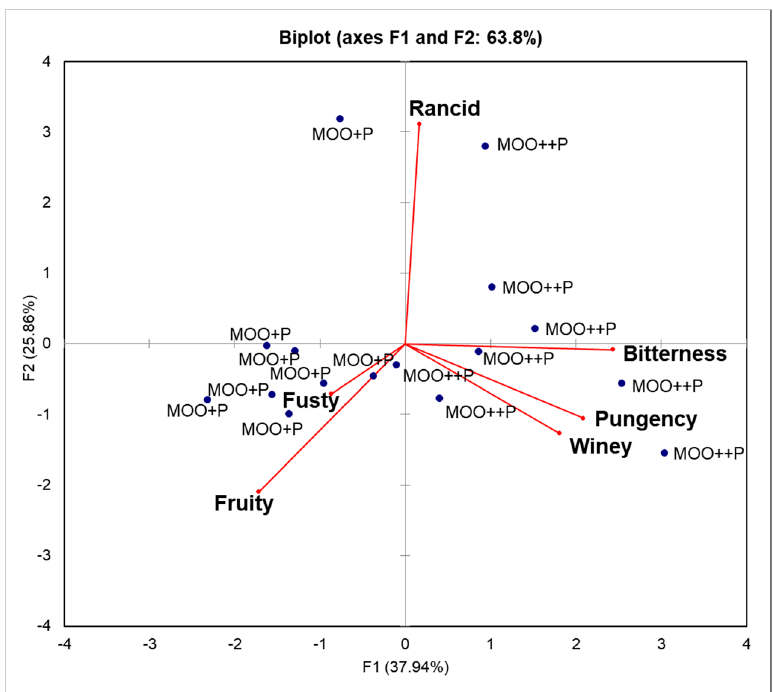
Figure 4. PCA based on sensory scores of the positive attributes of ‘fruity’, ‘bitterness’ and ‘pungency’ and the negative attributes of ‘rancid’, ‘winey–vinegary’ and ‘fusty–muddy’. MOO+P code indicates the lowest level of phenolic compounds in model olive oil, while MOO++P is the highest level. The sensory attributes were assessed by two different panels.